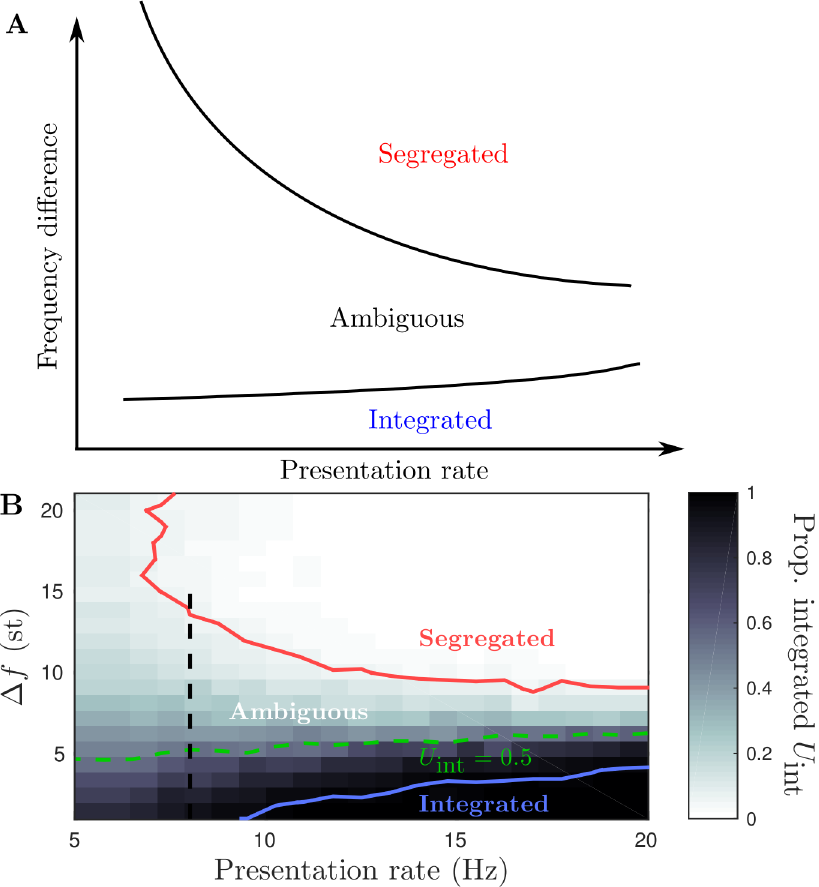
Fig 6. Perceptual organization for stimulus parameters. A : Schematic diagram of the perceptual regions in terms of presentation rate and frequency difference, redrawn after [2]. B : Grayscale map of proportion (of time) integrated U int (see Eq (2)), segregated region is above red contour at U int = 0.05, integrated region is below blue contour at U int = 0.95, ambiguous region lies in between with equidominance at U int = 0.5 along the dashed green contour. Vertical dashed line at PR = 8 corresponds to the frequency difference sweep used later in Figs 8 and 9.